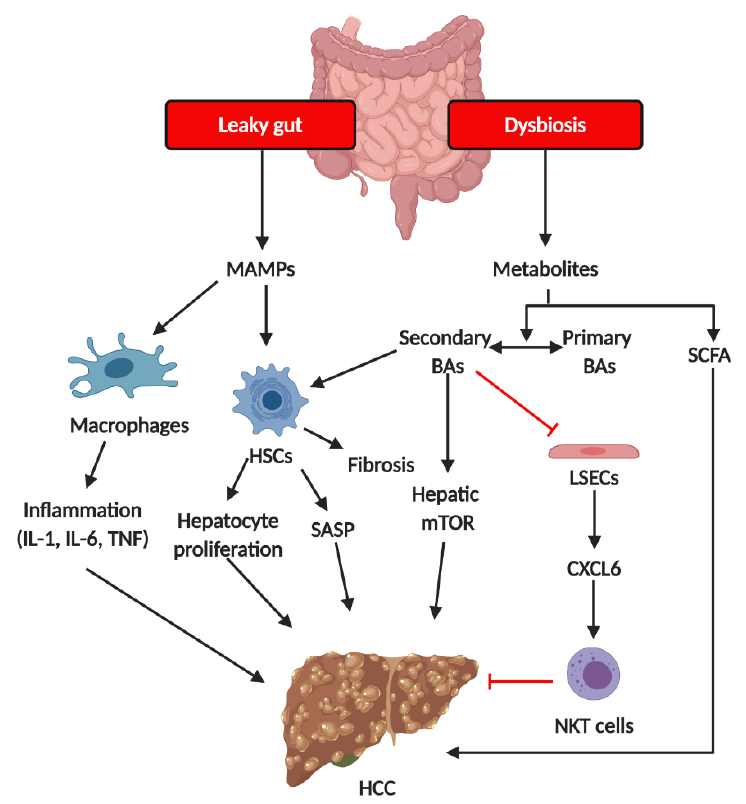
Figure 5. The mechanism of gut microbiota on the pathogenesis of HCC. Increased hepatic exposure to microbiota-derived metabolites and MAMPs results from dysbiosis and a leaky gut. Changes in BA pool (the ratio of primary BAs and secondary BAs) alter LSEC- and CXCL16-dependent NKT recruitment as well as HSC SASP. MAMPs induce the activation of macrophages, resulting in the production of pro-inflammatory cytokines including IL-1, IL-6, and TNF. Increased pro-inflammatory cytokines further contribute hepatic inflammation, which may also promote HCC development. MAMPs, microbiota-associated molecular patterns; HSCs, hepatic stellate cells; SASP, senescence-associated secretory phenotype; BAs, bile acids; LSECs, liver sinusoidal cells; SCFAs, short chain fatty acids; NKT cells, nature killer cells.